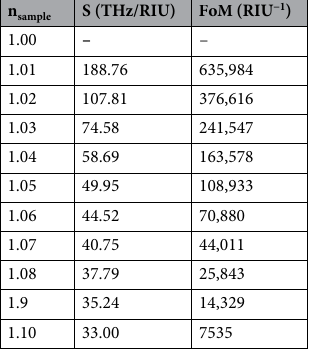
Table 1. Sensitivity and FoM at different ranges of n sample :